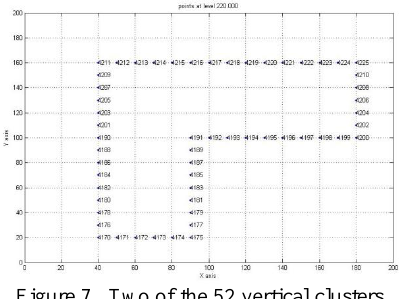
Figure 7. Two of the 52 vertical clusters